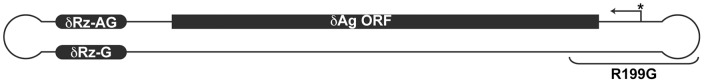
Representation of the hepatitis delta virus RNA genome.Both genomic (G) and antigenomic (AG) polarities of HDV RNA are superimposed; location of delta ribozyme (delta Rz) on each polarity is shown. The HDAg (delta Ag) coding region is indicated by the black rectangle and the transcription start site is depicted by an arrow and an asterisk. The location of the R199G fragment is indicated.